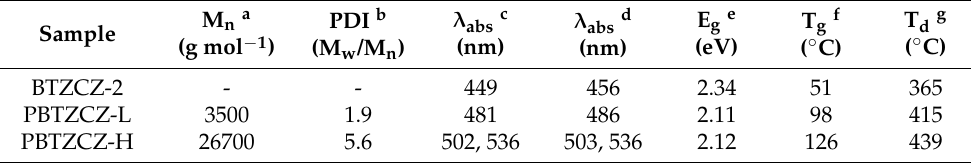
PBTZCZ-H a,b Determined by GPC with polystyrene as a standard and chlorobenzene as eluent; number-average molecular weight